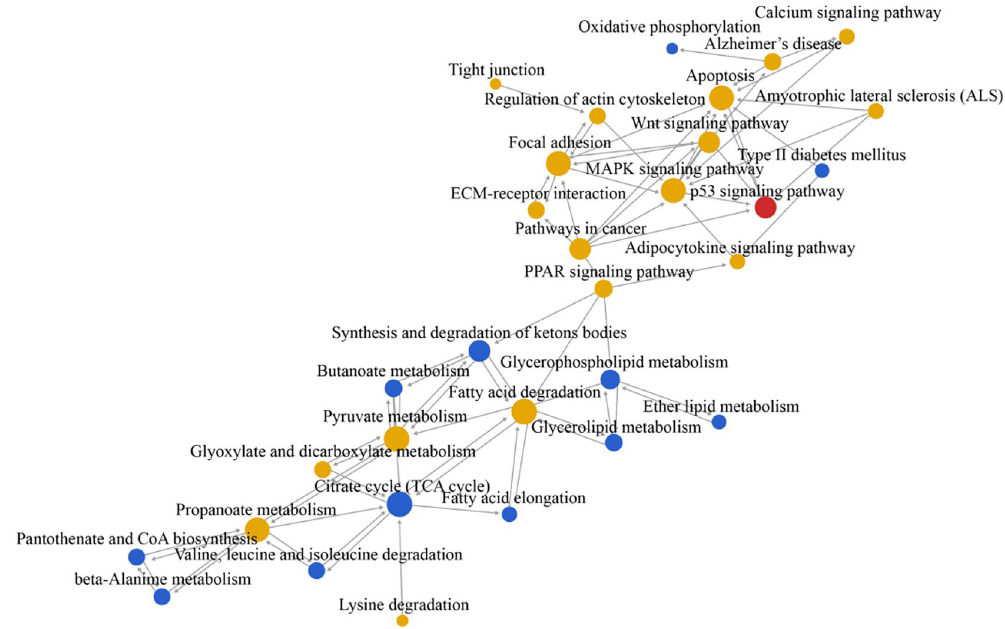
Figure 2. Network diagram of the interaction between the signalling pathways in the KEGG database based on their upstream and downstream relationships. Red dots indicate significant signalling pathways in which upregulated differentially expressed genes were involved, blue dots indicate the significant signalling pathway in which downregulated differentially expressed genes were involved, and yellow dots indicate significant signalling pathways in which both upregulated and downregulated differentially expressed genes were involved. Solid arrows indicate the upstream and downstream relationships between two signalling pathways, with the upstream signalling pathway at the start of the arrow and the downstream signalling pathway at the end of the arrow. Larger points indicate signalling pathways with a greater number of upstream and downstream effects (higher degree) and thus greater importance in the